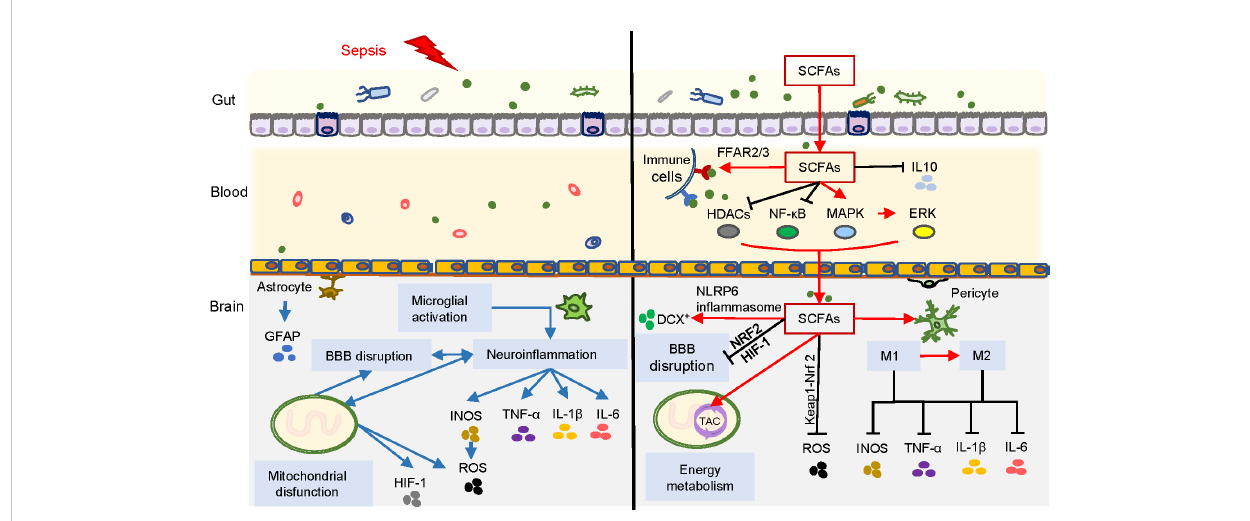
FIGURE 2 Overview of SCFAs correlated with SAE. Blue arrows on the left side of the fi gure represent the possible pathogenesis of SAE, involving neuroin fl ammation caused by microglial activation, as well as BBB damage and mitochondrial dysfunction. The right side of the fi gure represents the inhibition of neuroin fl ammation, immunomodulation, improvement of BBB function and energy metabolism exerted by SCFAs through different pathways during SAE (red arrows represent promotion, and black lines represent